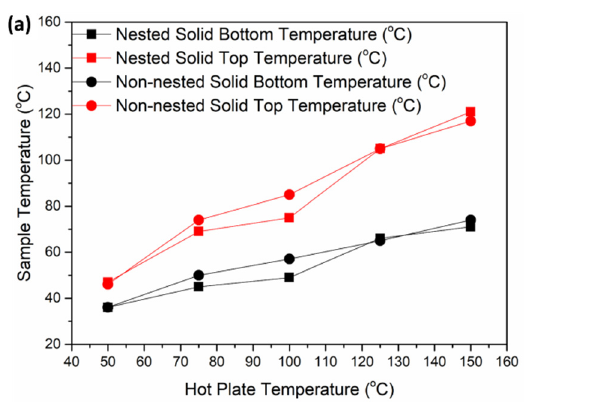
Figure 10. ( a ) Variation of top and bottom surface temperatures of the cellular solids with hotplate temperature; and ( b ) insulating performance of the cellular solids with hotplate temperature.